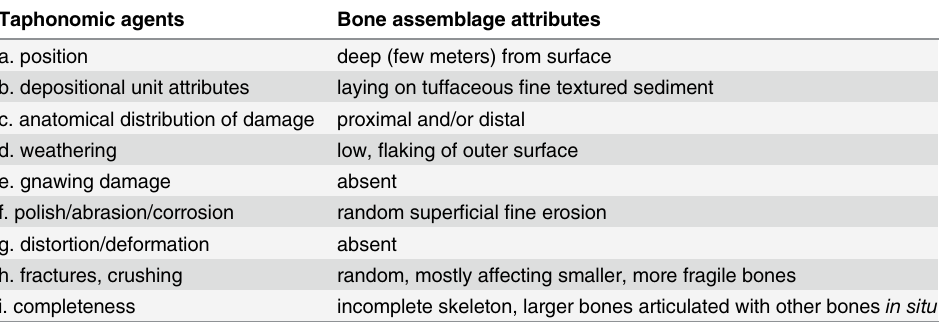
Table 3. Taphonomic (biological, geological, human) agents possibly involved in causing the skull